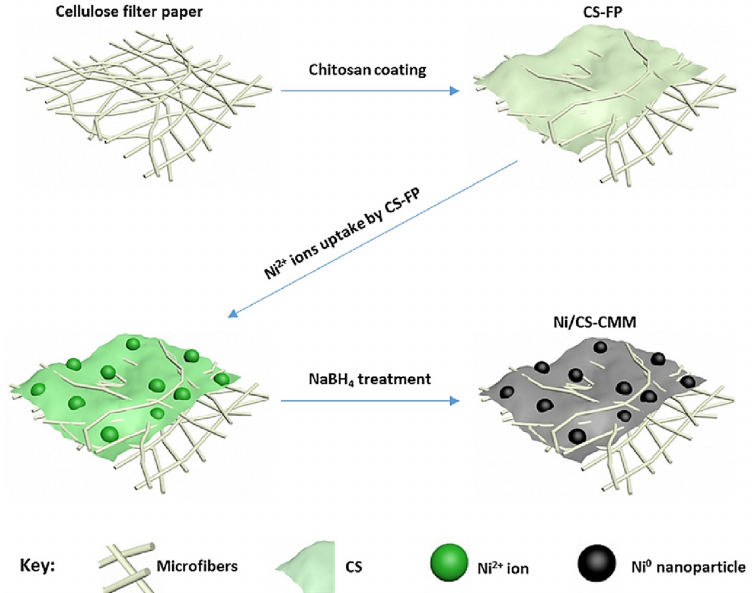
Figure 15. Steps in the preparation of Ni/CS filter paper. Reprinted from [40]. Copyright 2016 with permission from Elsevier.